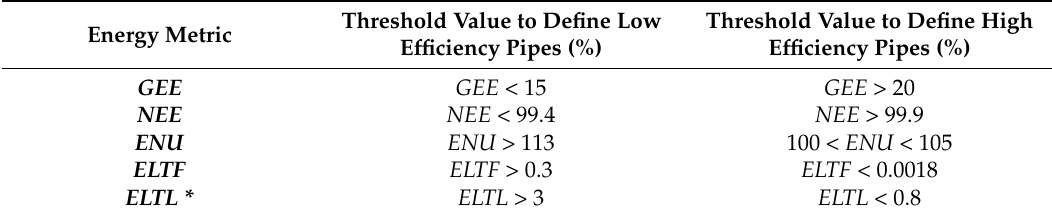
Table 4. Threshold values to define high and low efficiency pipes by [11,23] in both non-leaky and leaky